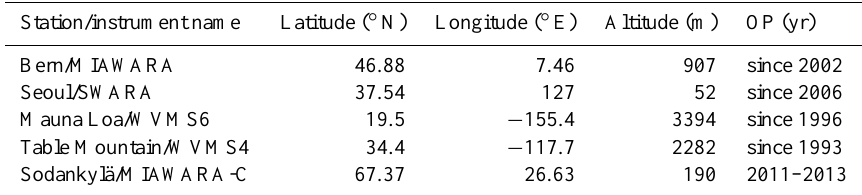
Table 1. Locations of middle atmospheric water vapor radiometers used in this study with the geolocation and operational period of each station (OP). MIAWARA-C is a campaign instrument.